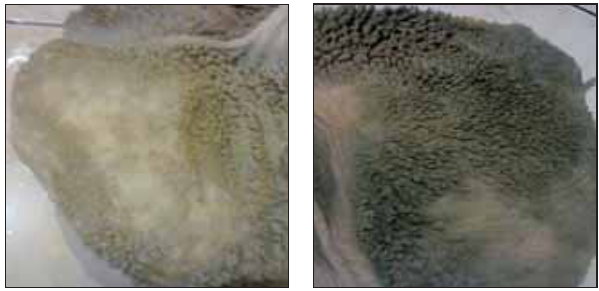
Figure-5: Necropsy finding of affected rumen shows stunted and sloughed ruminal